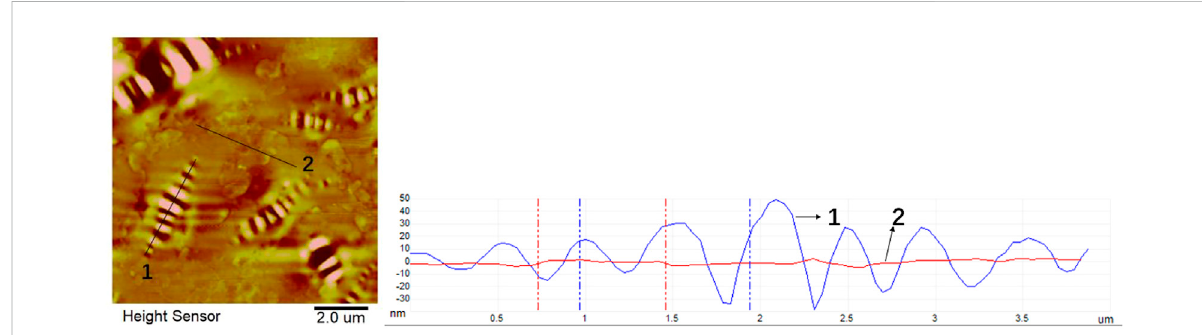
FIGURE 3 Height variation diagram of asphalt structure area with different phases, as observed by